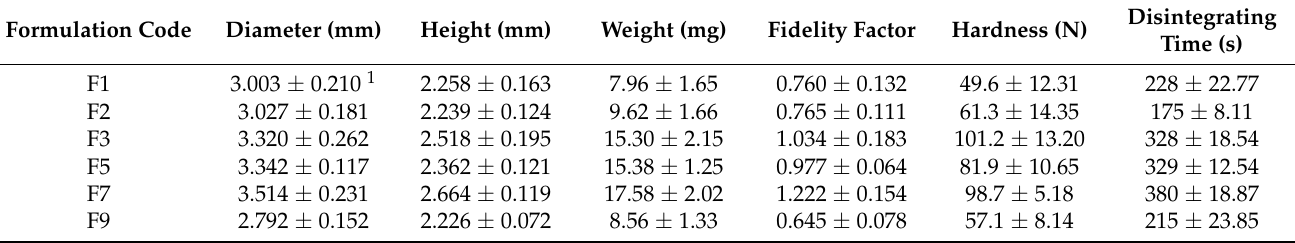
Table 7. Characterisation of ODMT formulation in DoE.